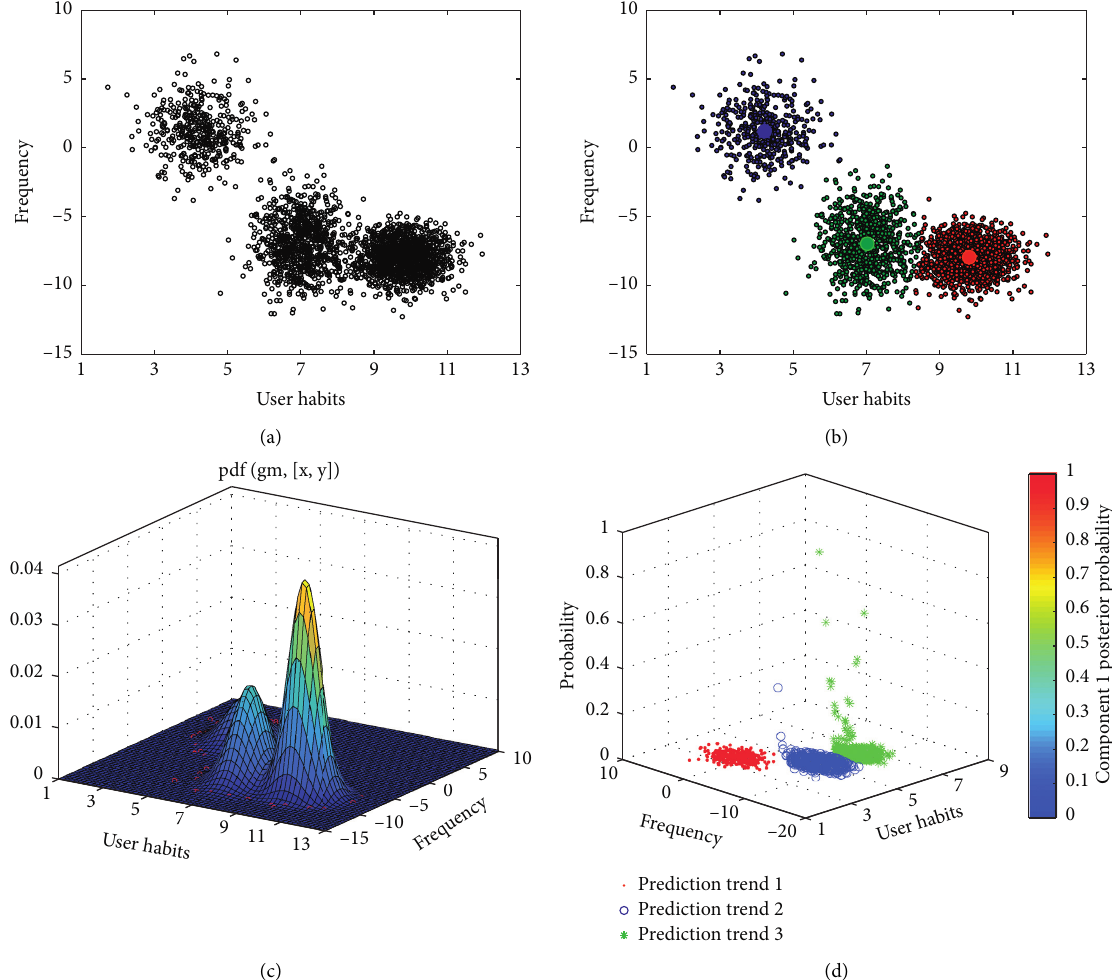
Figure 7: The simulation results of the proposed method. (a) Original data. (b) Data mining results. (c) Thermal energy diagram. (d) Probability figure of user habits.